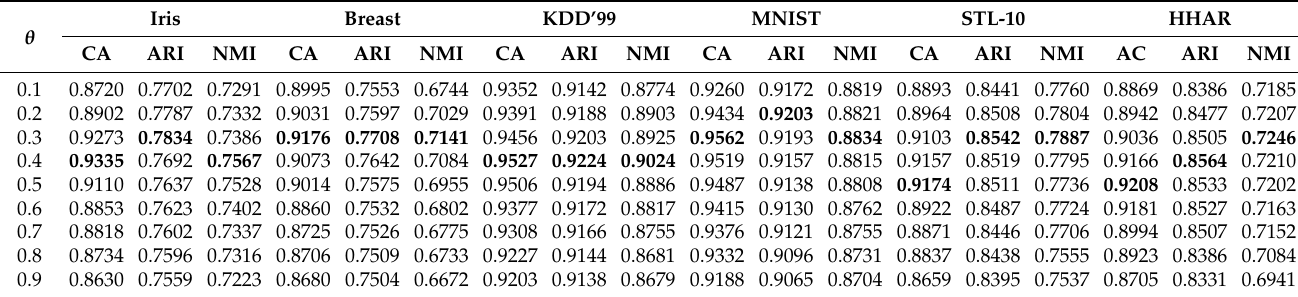
Table 9. Ensemble results of the CEvGE algorithm with different values of hyperparameter θ